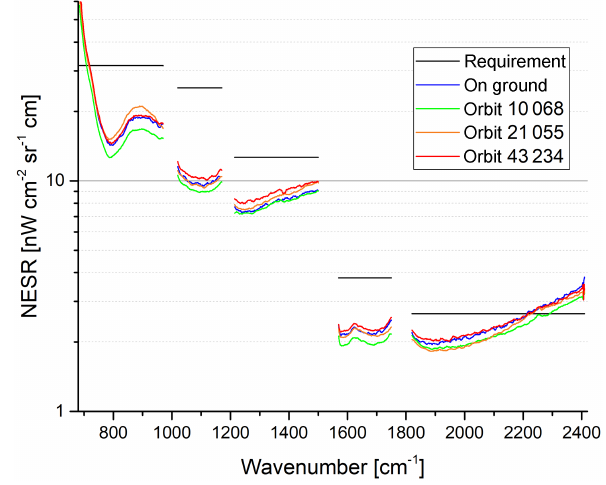
Figure 3. NESR 0 values on ground and in flight for selected orbits along the